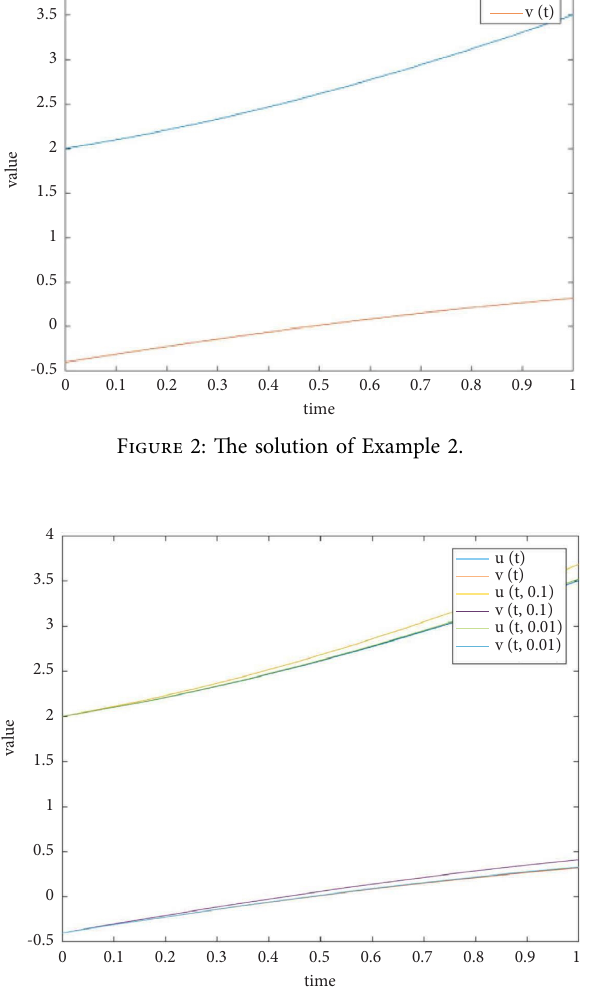
Figure 3: Te UH-stability of Example 2 with ε � 0 . 1 , 0 .